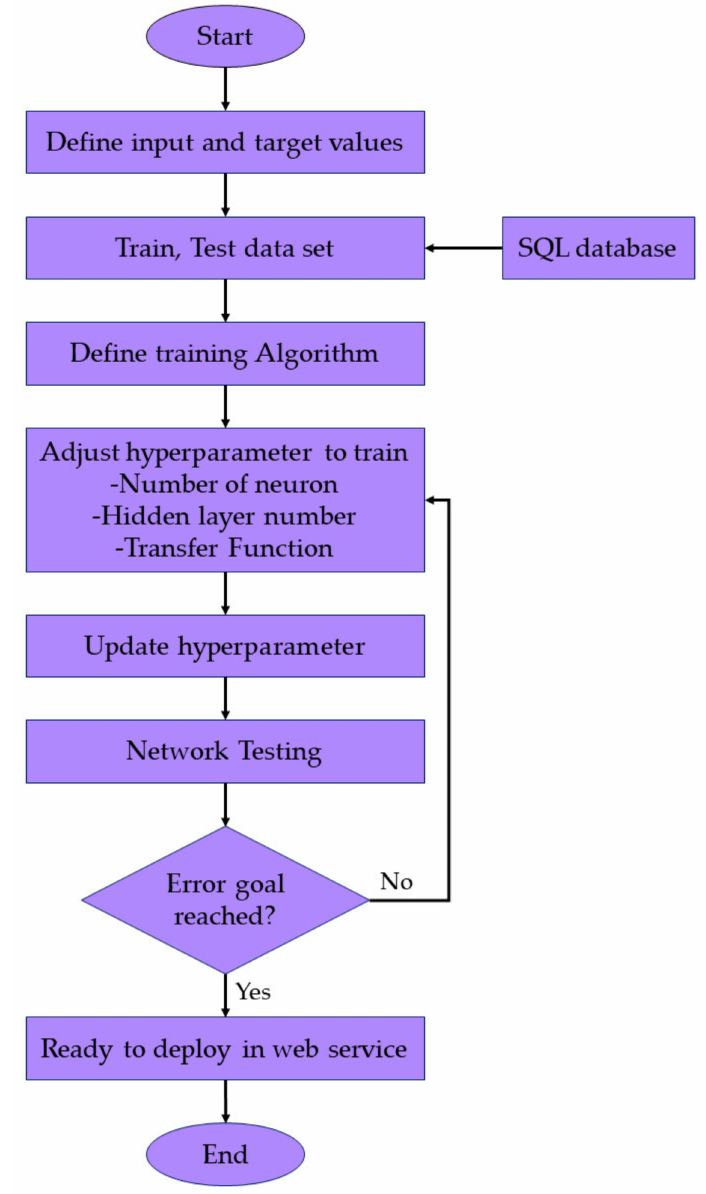
Figure 8. Steps in the development of the MLP neural network